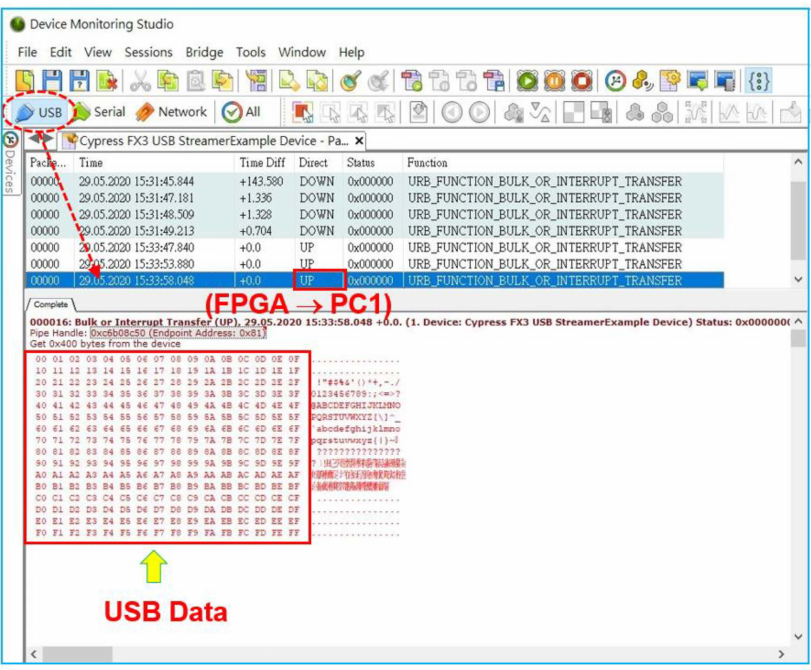
Figure 17. Transmitted USB data from the FPGA development kit to PC1 (UP) via the USB 3.0